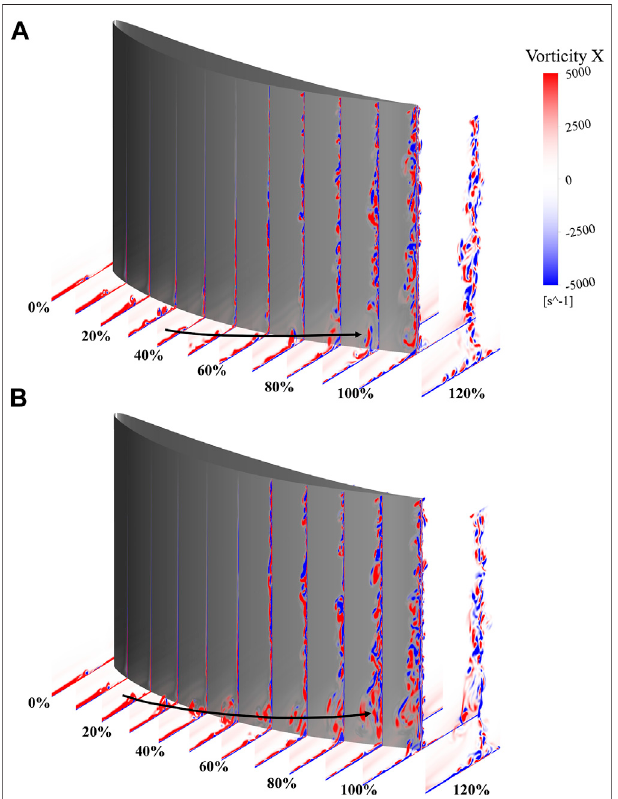
FIGURE 9 | Evolution of the axial vorticity for the PS con fi guration. (A) t = T; (B) t = T + 1/2 τ .